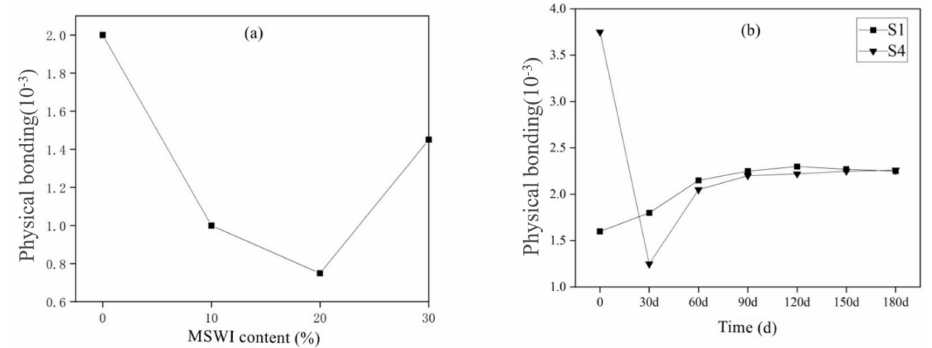
Figure 12. Chloride ion physical bonding amount of MSWI recycled cement-based material at different dosage ( a ) and age ( b